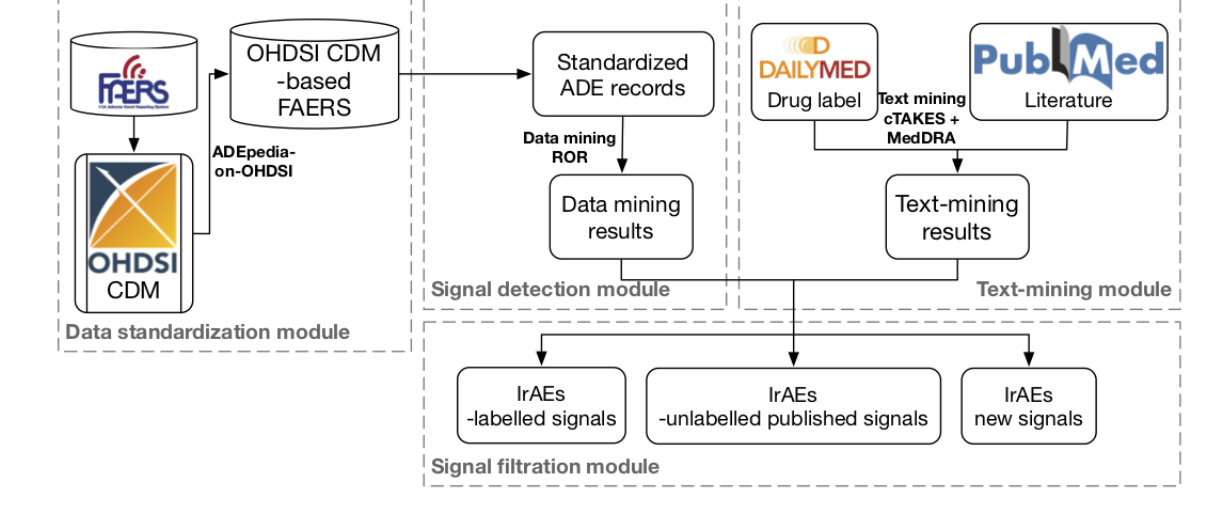
Figure 1. System architecture of our standards-driven framework. ADE: adverse drug events; CDM: common data model; cTAKES: clinical text analysis and knowledge extraction system; FAERS, Food and Drug Administration’s adverse event reporting system; IrAEs: immune-related adverse events; MedDRA: medical dictionary for regulatory activities; OHDSI: observational health data sciences and informatics; ROR: reporting odds